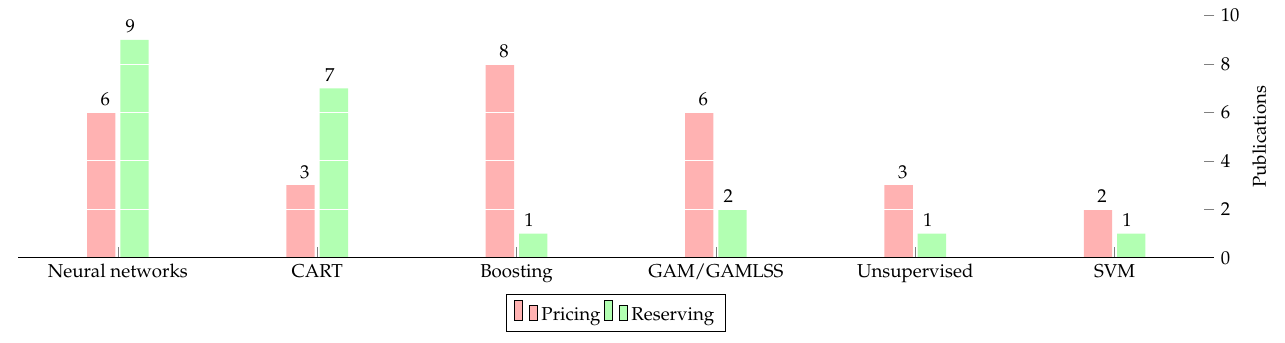
Figure 3. Number of publications by